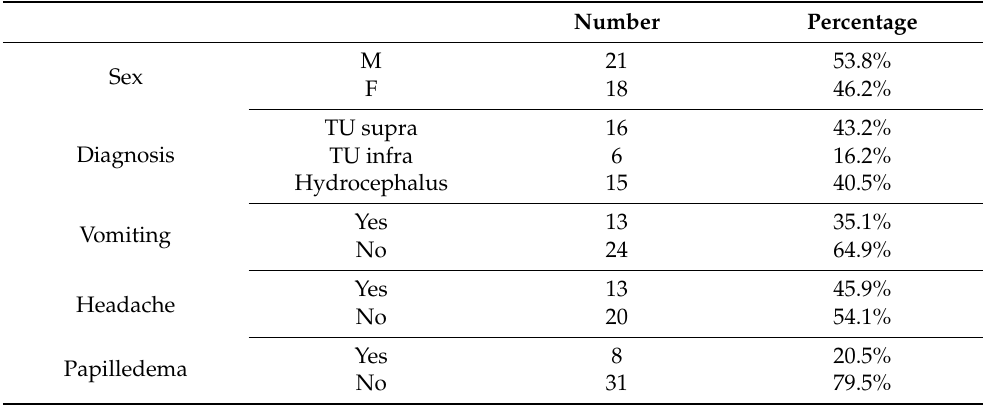
Table 2. Distribution of the symptoms, sex, and diagnosis type in the following groups.